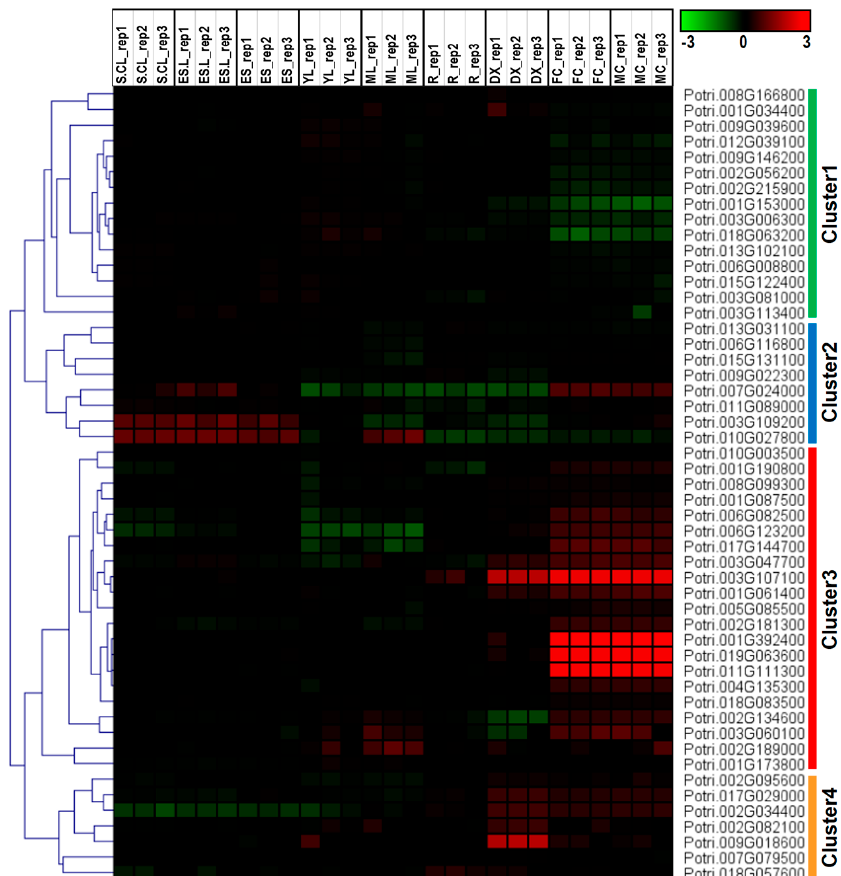
Figure 5. Expression profiles of genes coding DEPs between ‘ZH1’ and ‘ZH2’ mature pollen across different tissues. The Affymetric microarray data were obtained from the National Center for Biotechnology Information (NCBI) Gene Expression Omnibus (GEO) database under the series accession number GSE13990. S.CL—Seedling continuous light; ES.L—Etiolated seedling 6 days transferred to light 3 h; ES—Etiolated seedling; YL—Young leaf; ML—Mature leaf; R—Root; DX—Differentiating xylem; FC—Female catkin; MC—Male catkin. Background-corrected expression intensities were log-transformed and visualized as heatmaps. Color scale represents log2 expression values, green represent low level and red indicates high level of transcript abundance.